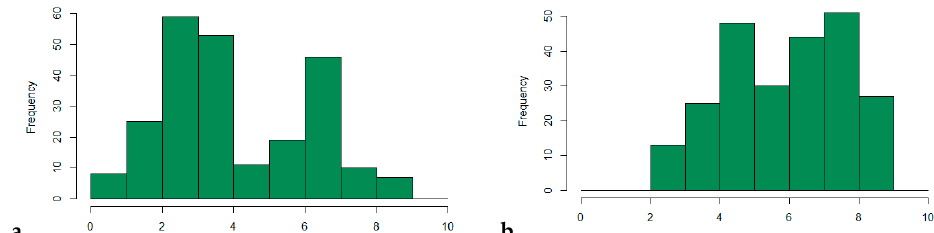
Figure 1. Distribution of the phenotypic scores among the 239 genotypes in the core collection for crown rust ( a ) and brown rust ( b ). The x -axis refers to the scale used for the disease scoring, where 1 refers to heavy attack (high susceptibility) and 9 corresponds to no rust infection (high tolerance). Table 1. Summary statistics and trait repeatability estimates for BR and CR. Min refers to the lowest scored value; Max refers to the highest scored value; SD refers to the standard deviation, Cvar refers to the coefficient of variation.